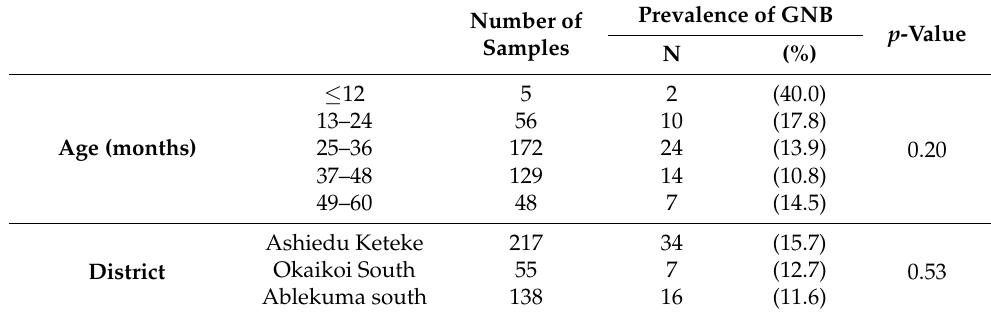
Table 1. Prevalence of aerobic Gram-negative bacteria (by age, sex, and district) isolated from the nasopharynx of healthy under-five children in Accra, Ghana, from September to December 2016. Table 1. Cont .